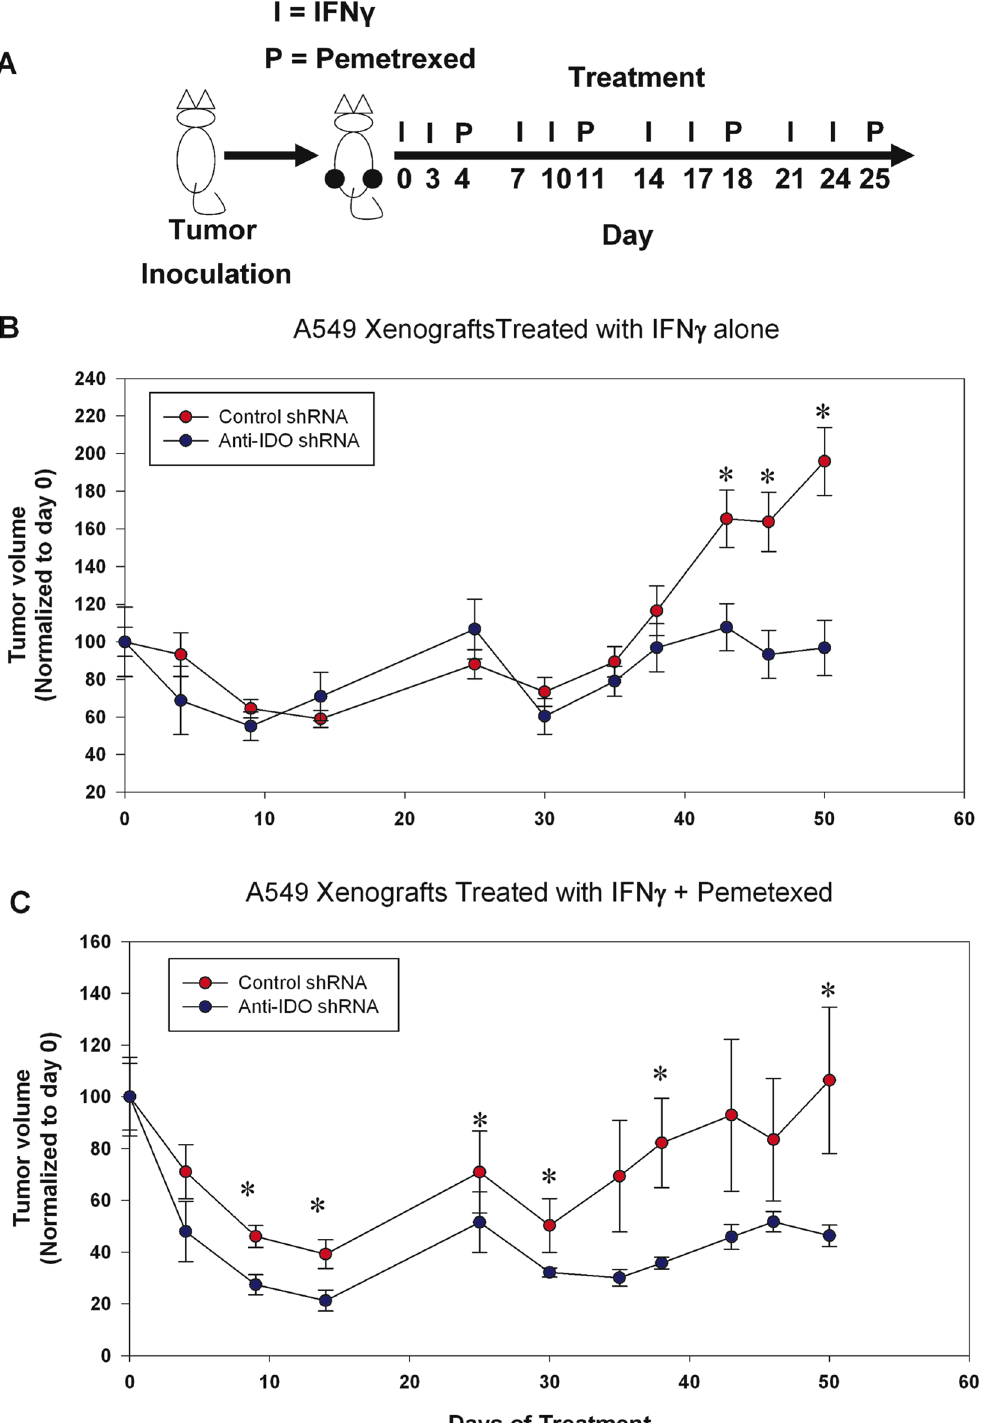
Fig 10. IDO downregulation sensitized A549 xenografts to pemetrexed treatment. A : Ten million A549 cells transfected with control shRNA (clone NC- 3) or anti-IDO shRNA (clone 2 – 18) were injected into flanks of SCID mice. Once tumors reached ~300 mm 3 animals were injected with 100,000 IU IFN γ i.p. (twice a week for four weeks) and 50 mg/kg pemetrexed i.p. (once per week for four weeks). Animals transplanted with A549 clonal cells transfected with control shRNA or anti-IDO shRNA received four weeks of IFN γ treatment alone (B) or IFN γ and pemetrexed (C) . Tumor growth was monitored with caliper measurement to estimate tumor volume. * Significant difference, Student's t -test, p < 0.05.